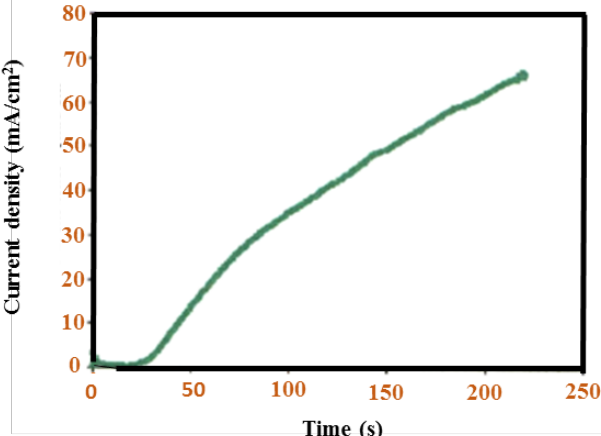
Figure 18. PANI film with potentiostatic deposition. Reproduced from Eur. Polym. J., 125, Kumari Jangid, N.; Jadoun, S.; Kaur, N., A review on high-throughput synthesis, deposition of thin films, and properties of polyaniline, Copyright (2020), with permission from Elsevier.